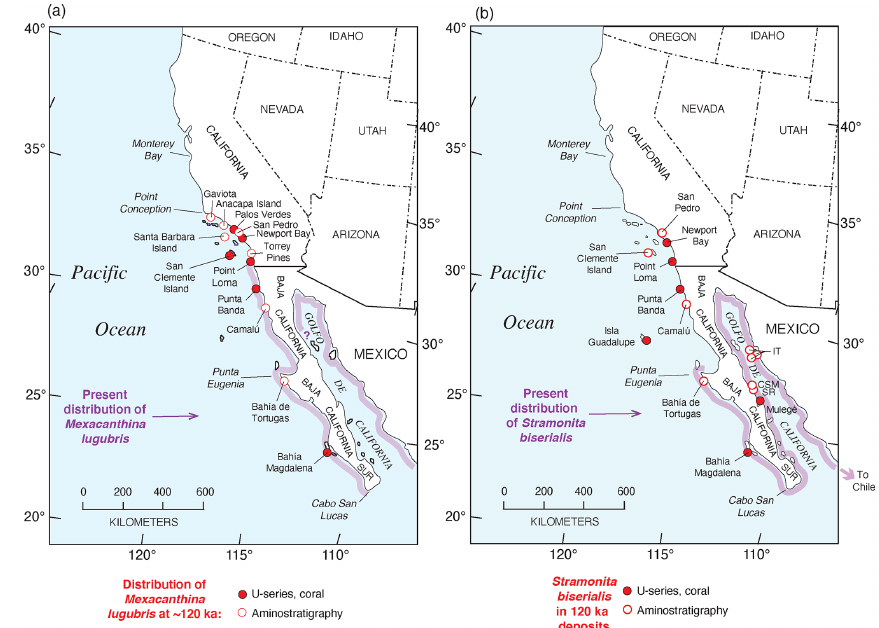
Figure 41. Examples of extralimital southern species of gastropods indicating sea surface temperatures higher than present during MIS 5e (filled and open circles); also shown, in light purple shading, are the modern ranges of these taxa (from Bertsch and Aguilar Rosas, 2016, and Keen, 1971): (a) Mexacanthina lugubris and (b) Stramonita biserialis . Age and faunal data compiled from Jordan (1936), Kanakoff and Emerson (1959), Valentine (1962, 1980), Lipps et al. (1968), Kern (1977), Ashby et al. (1987), Omura et al. (1979), Lindberg et al. (1980), Emerson et al. (1981), Ortlieb (1987), Rockwell et al. (1989), Muhs (1983), Muhs et al. (1992, 2002a, 2014a), Grant et al. (1999), and Wehmiller and Pellerito (2015). Note that the presence of Stramonita biserialis on San Clemente Island is from a recent discovery of this taxon by Lindsey T. Groves, Natural History Museum of Los Angeles County, from the NOTS Pier terrace (Muhs, 1983), correlated to the Eel Point terrace ( ∼ 120ka; Muhs et al., 2002a) by amino acid ratios in mollusks.